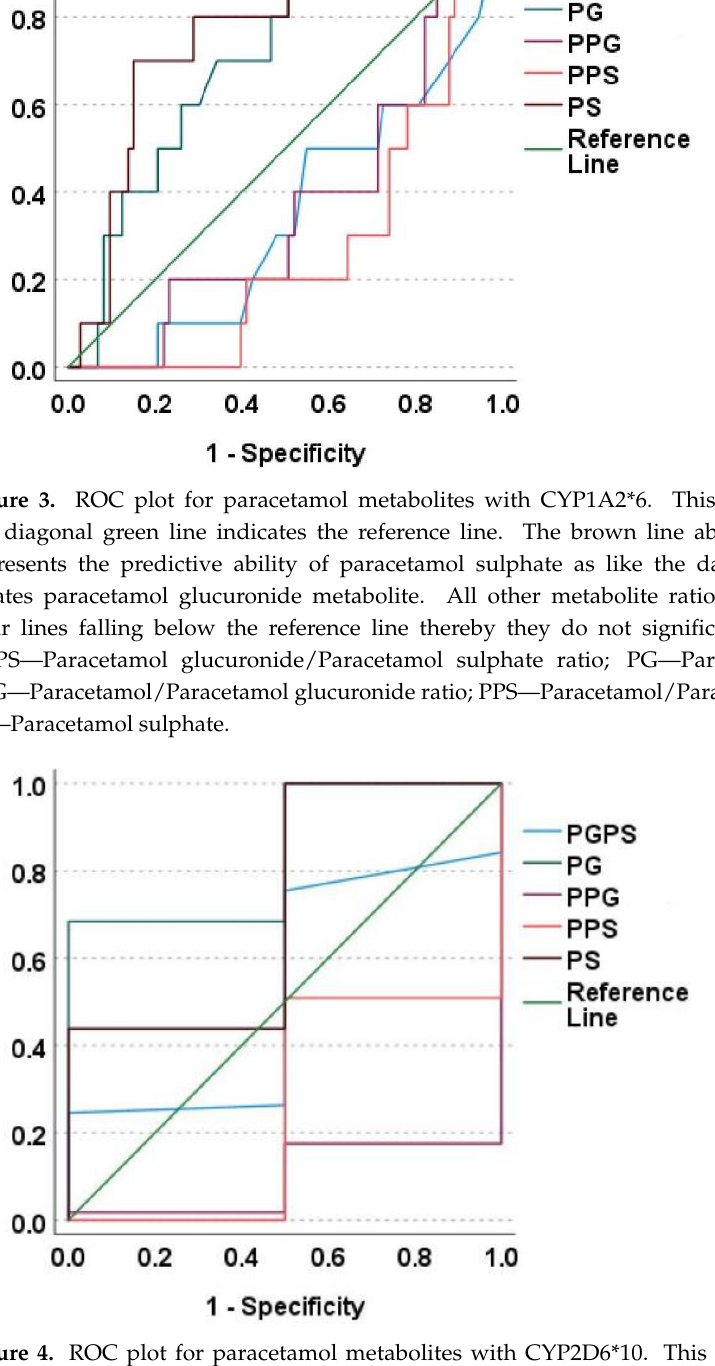
Figure 4. ROC plot for paracetamol metabolites with CYP2D6*10. This is a ROC curve where the diagonal green line indicates the reference line. The dark green line above the reference line represents the predictive ability of paracetamol glucuronide. All other metabolites/metabolite ratios were observed with their lines falling below the reference line thereby they do not significantly predict the SNP. PGPS—Paracetamol glucuronide/Paracetamol sulphate ratio; PG—Paracetamol glucuronide; PPG—Paracetamol/Paracetamol glucuronide ratio; PPS—Paracetamol/Paracetamol sulphate ratio; PS—Paracetamol sulphate. Table 2. Association between the SNPs and serum concentrations of paracetamol and its metabo- lites.